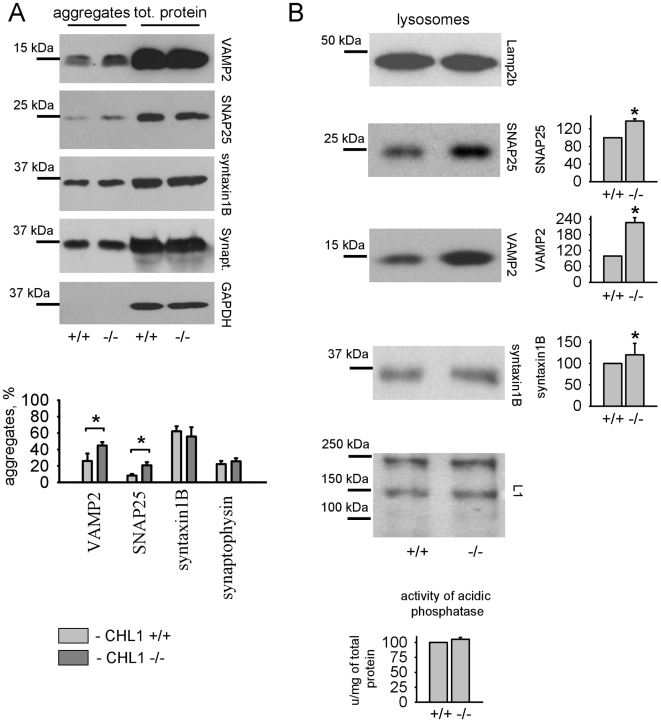
CHL1 deficiency results in aggregation and lysosome targeting of VAMP2 and SNAP25.
A - Protein aggregates and total protein from CHL1+/+ and CHL1−/− brains were probed by Western blot with the indicated antibodies. Note that higher levels of VAMP2 and SNAP25 are present in aggregates from CHL1−/− brain homogenates. Graph shows mean protein levels in aggregates ± SEM (n = 6) normalized to the total protein level. *p<0.05, paired t-test. B - CHL1+/+ and CHL1−/− lysosomes were probed by Western blot with antibodies against the lysosome associated proteins Lamp2b, SNAP25, VAMP2 and syntaxin1B. L1 served as a loading control. Graphs on the right show mean levels ± SEM of SNAP25, VAMP2 and syntaxin1B in lysosomes with levels in CHL1+/+ lysosomes set to 100%. Note similar levels of Lamp2b in CHL1+/+ and CHL1−/− lysosomes indicating similar efficiency of lysosome isolation. Graph (below) shows mean levels ± SEM of acidic phosphatase activity in CHL1+/+ and CHL1−/− lysosomes that was similar in lysosomes of both genotypes, again indicating that similar levels of lysosomes were isolated. Levels of SNAP25, VAMP2, syntaxin1B, but not L1 are increased in CHL1−/− lysosomes. *p<0.05, paired t-test.